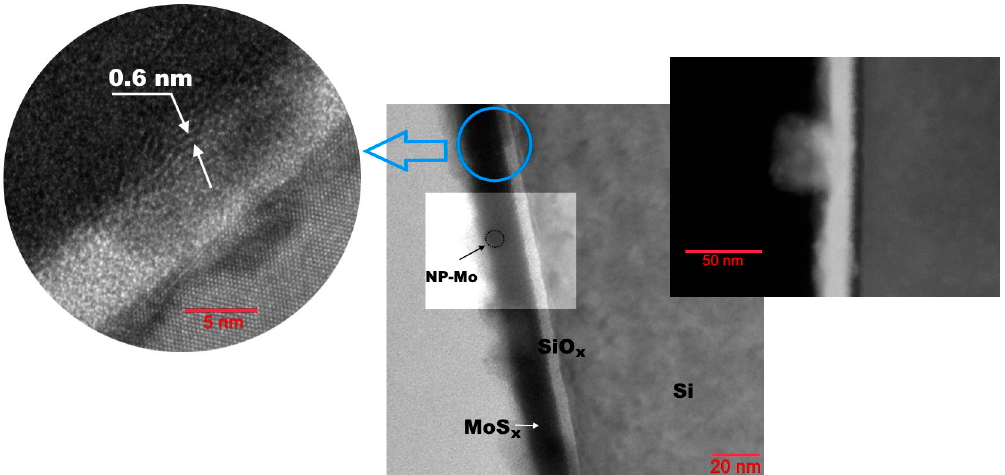
Figure 13. Cross section HRTEM (left), TEM (center), and HAADF (right) images for a-MoS x /NP-Mo//n + p-Si photocathode tested in a photoelectrochemical cell for 20 min.